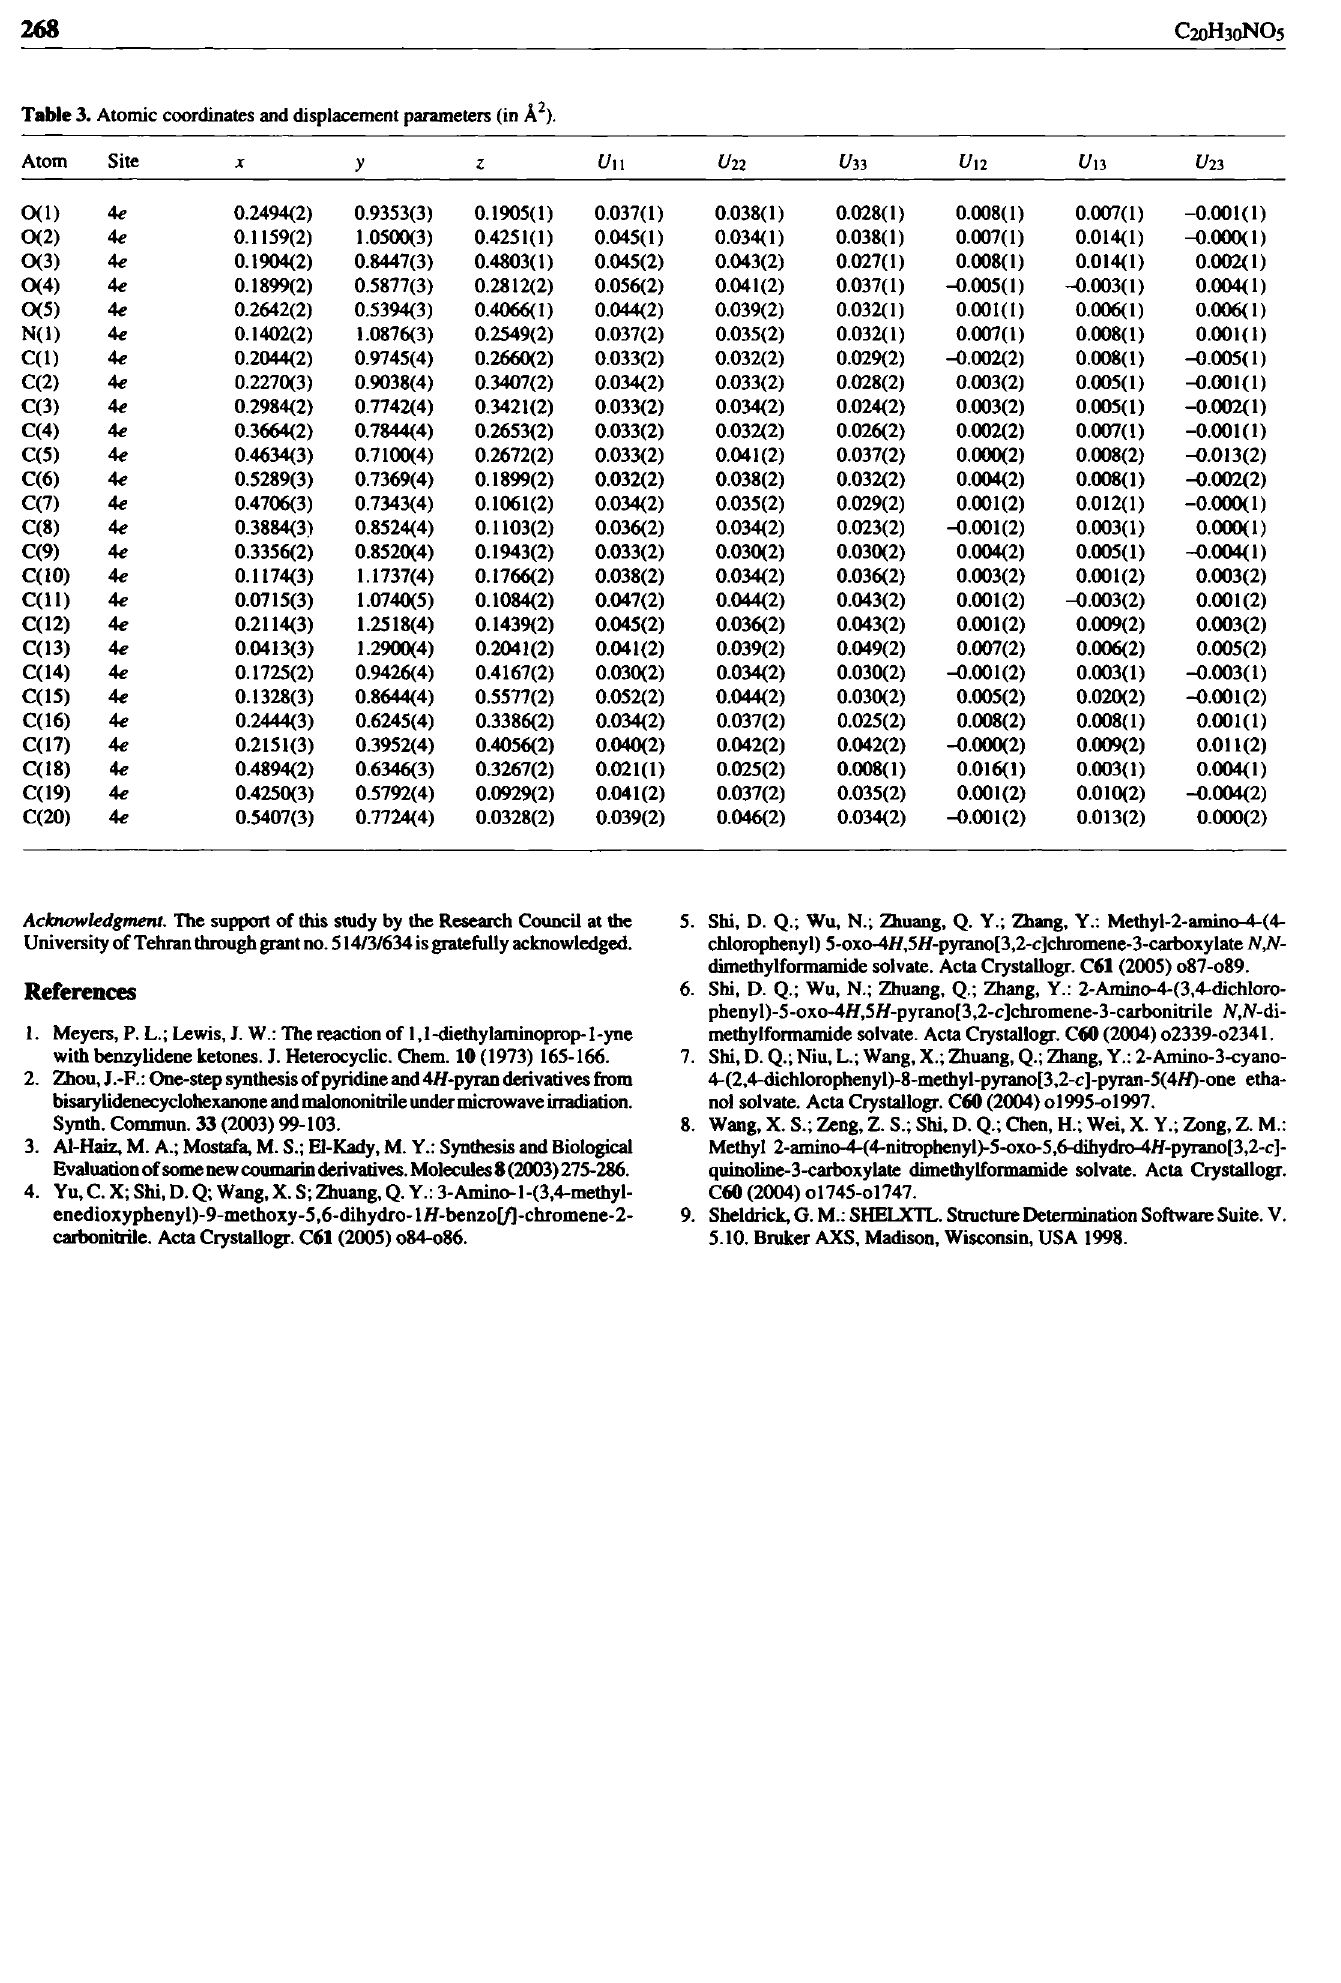
Table 3. Atomic coordinates and displacement parameters (in A 2